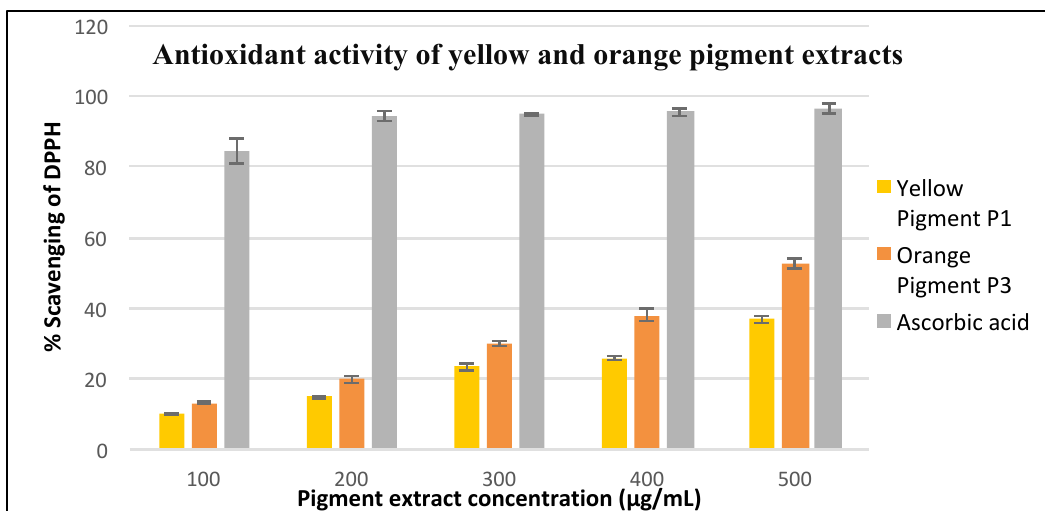
FIGURE 4 – Antioxidant activity of methanolic extracts (100-500 µg/mL) of pigments. % scavenging of DPPH. Each bar represents three trials expressed as mean ±